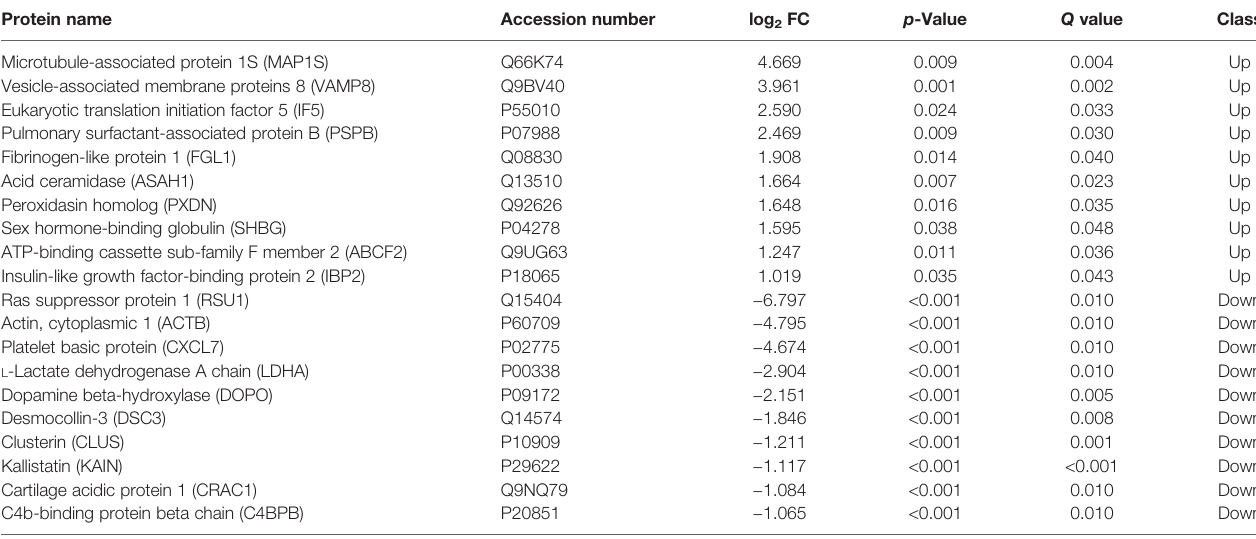
TABLE 2 | Statistics of differential proteins between total patients with GD and healthy